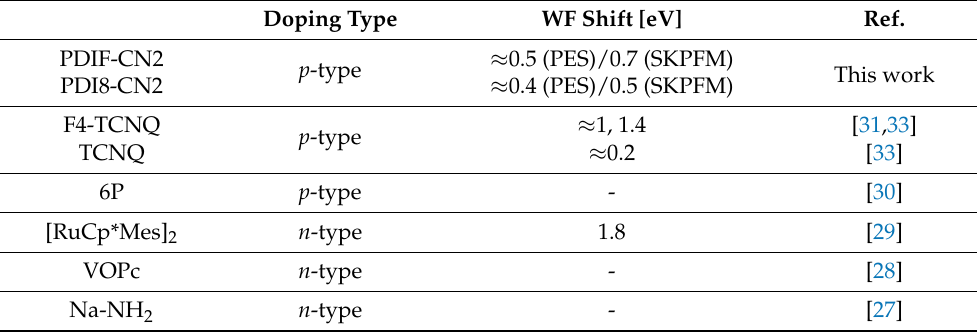
Table 3. Doping type and typical work function (WF) shift for the different organic molecules reported in the literature and in comparison with the results obtained in this